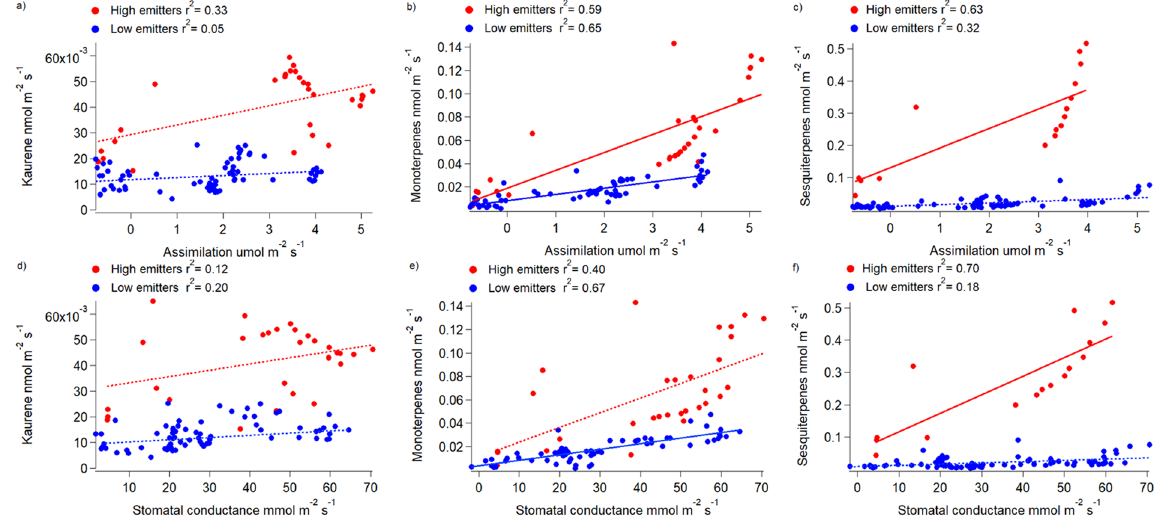
Figure 3. Linear correlations of CO 2 assimilation rate (upper part) and stomatal conductance (bottom part) with kaurene ( a , d ), monoterpenes ( b , e ) and sesquiterpenes ( c , f ) emission rates for the diurnal cycles measurements of seven individuals of H . halimifolium . Red dots represent the high emitter group and blue dots the low emitter group. Thick lines represent a correlation and dashed lines represent a lack of correlation. Note that for sesquiterpenes only one plant represents the high emitter group. R 2 are shown in the legend, all correlations were statistically significant (p < 0.001) except for the relationship between kaurene emission rates and CO 2 assimilation